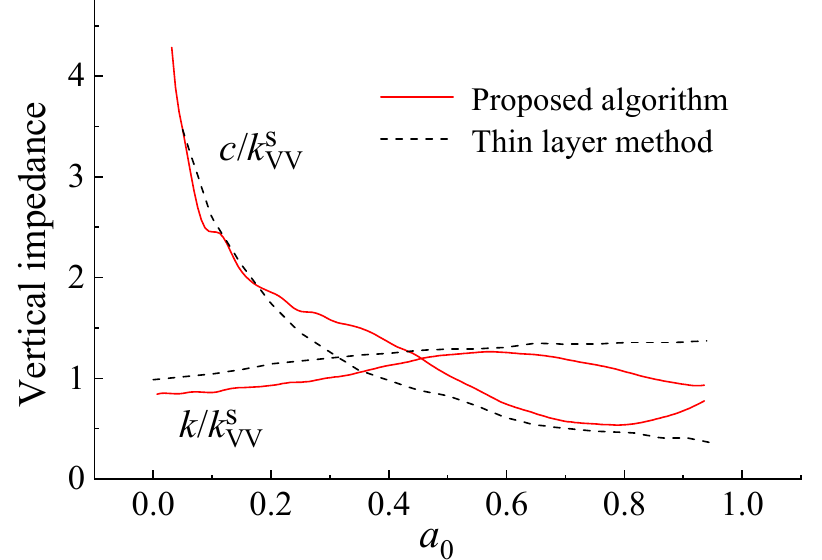
Figure 3. Vertical impedance function of a single pile compared with the thin layer method.